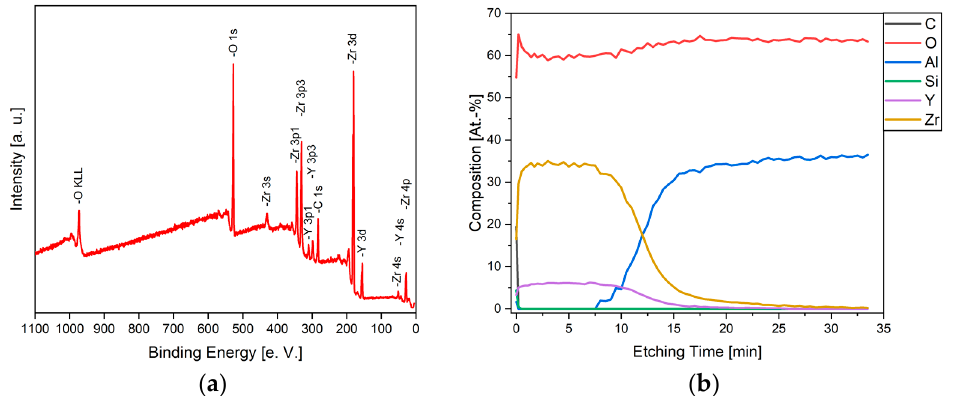
Figure 6. ( a ) XPS surface survey of the RF-oxide_as-sputtered sample and ( b ) depth-profile of the